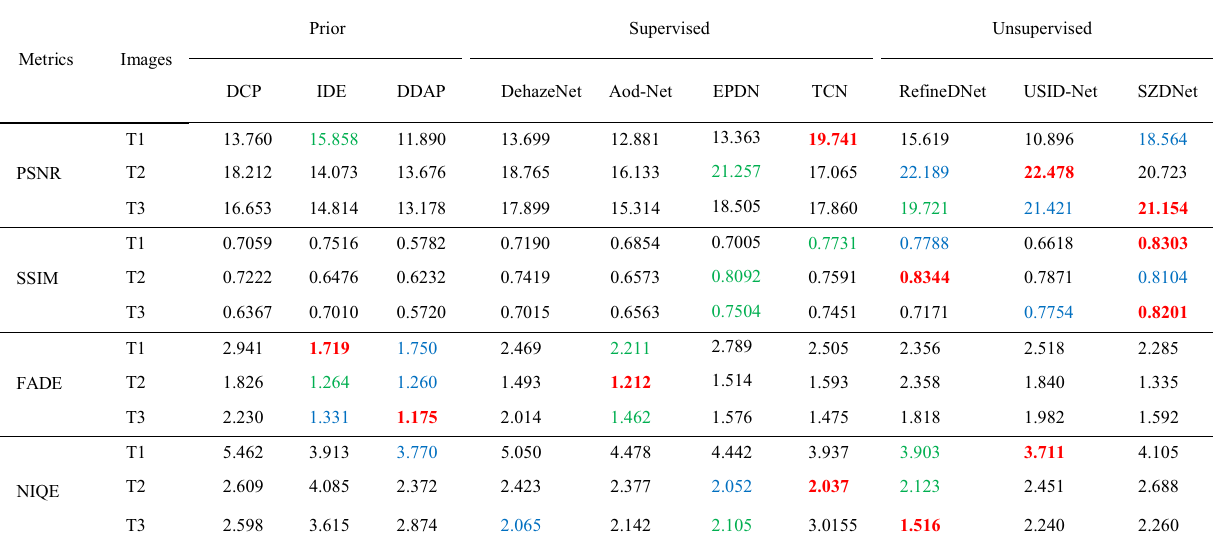
Table 3 Qualitative comparison between SZDNet and the SOTA dehazing method on images. The best, second best, and third best perfor- mances are marked in red, blue, and green, respectively